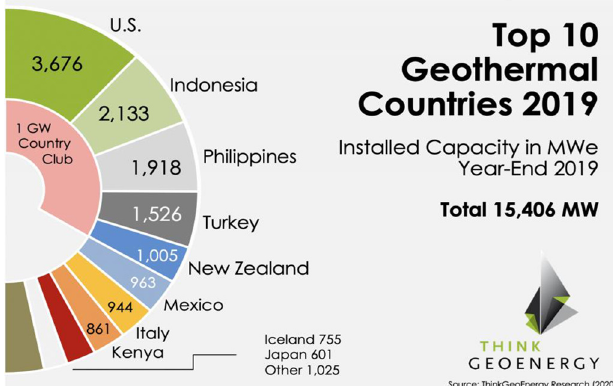
Fig. 5. CO 2 emission and imbedded carbon of all power generation sources. Fig. 6. The Top 10 Geothermal Countries 2019